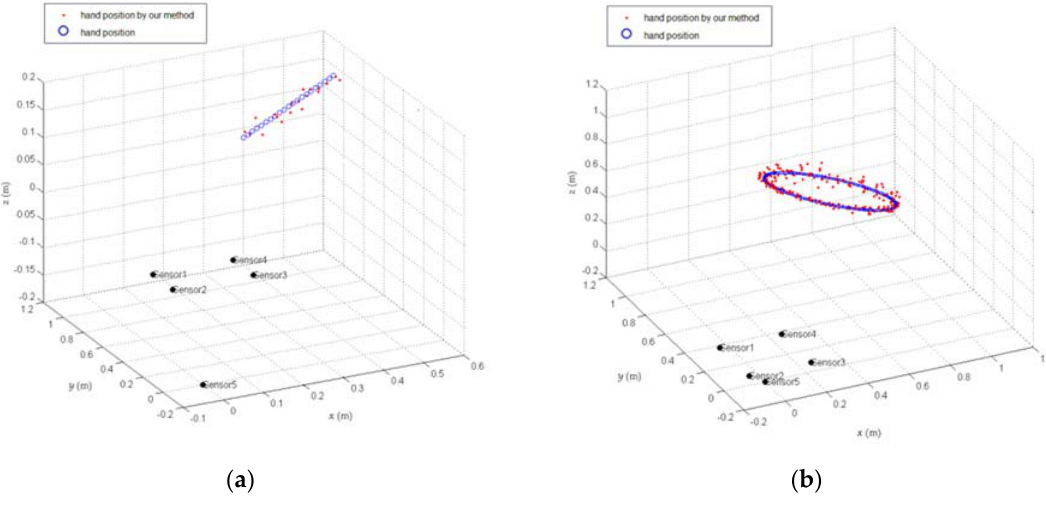
Figure 15. Position solution results by adding 10% noise into signal for ( a ) a linear trajectory and ( b ) a circular trajectory. ( b ) a circular trajectory.